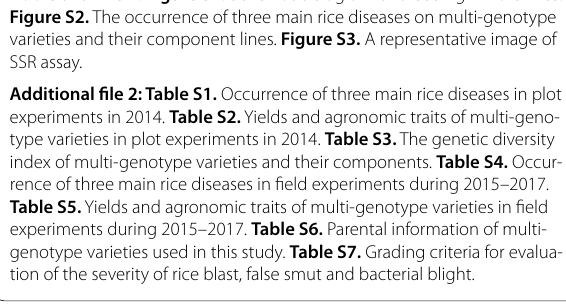
varieties and their component lines. Figure S3. A representative image of SSR assay. Additional file 2: Table S1. Occurrence of three main rice diseases in plot experiments in 2014. Table S2. Yields and agronomic traits of multi‑geno‑ type varieties in plot experiments in 2014. Table S3. The genetic diversity index of multi‑genotype varieties and their components. Table S4. Occur‑ rence of three main rice diseases in field experiments during 2015–2017. Table S5. Yields and agronomic traits of multi‑genotype varieties in field experiments during 2015–2017. Table S6. Parental information of multi‑ genotype varieties used in this study. Table S7. Grading criteria for evalua‑ tion of the severity of rice blast, false smut and bacterial